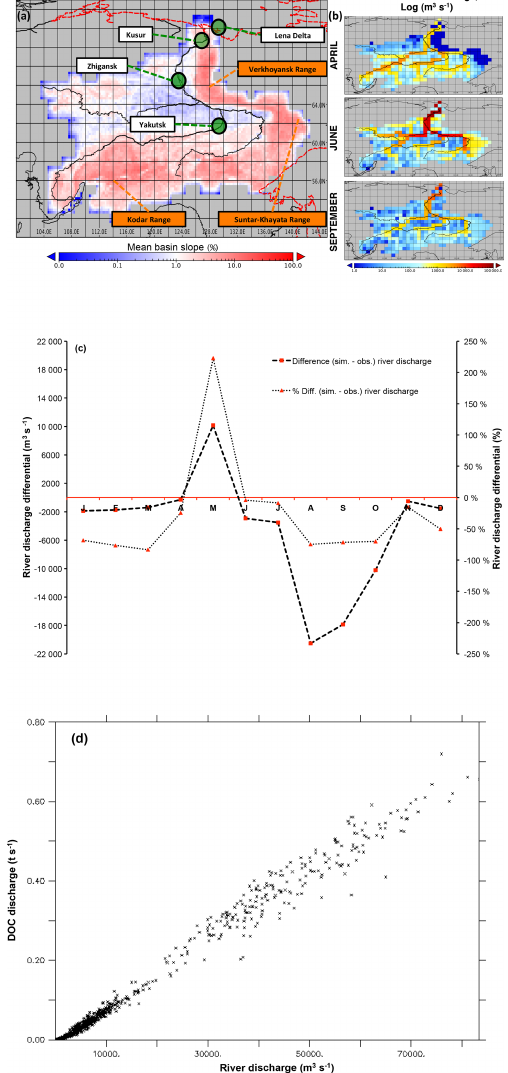
Figure 3. Map of the Lena (a) with the scale bar showing the mean grid cell topographic slope from the simulation, and the black line showing the satellite-derived overlay of the river main stem and sub- basins. Mountain ranges of the Lena basin are shown in orange. Green circles denote the outflow grid cell (Kusur) from which our simulation outflow data are derived, as well as the Zhigansk site, from which evaluation against data from Raymond et al. (2007) are assessed. The regional capital (Yakutsk) is also included for geographic reference. Coastal outline and inland water bodies are shown as dashed red and solid black lines, respectively. (b) Maps of river water discharge (log(m 3 s − 1 )) in April, June, and Septem- ber, averaged over 1998–2007. (c) The mean monthly river dis- charge differential between observed discharge for the Lena (Ye et al., 2009) and simulated discharge averaged over 1998–2007 in ab- solute (m 3 s − 1 ) and percentage terms. (d) Regression of simulated monthly DOC discharge versus simulated river discharge at the river mouth (Kusur) over the entire simulation period